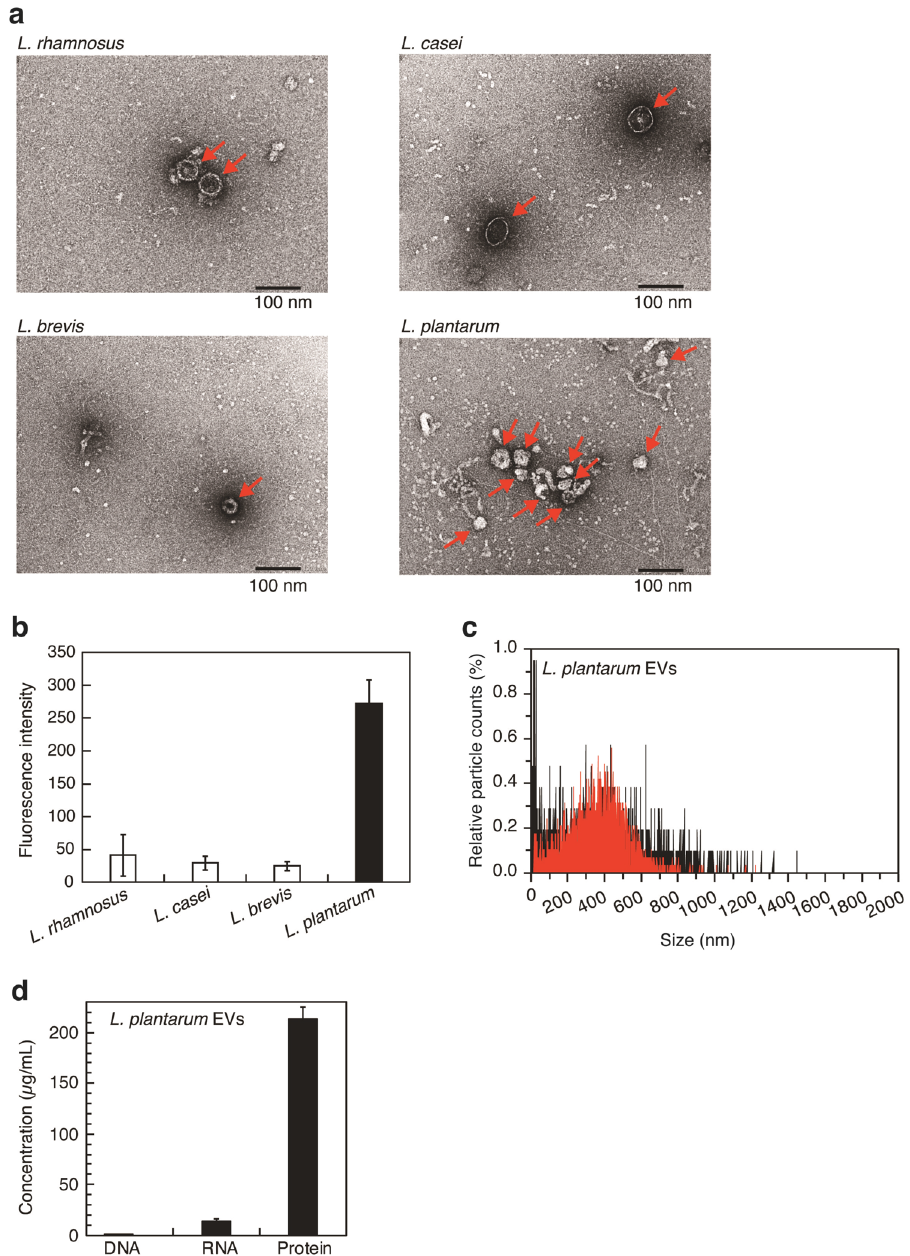
Figure 2. Characterization of EVs produced by L . plantarum. ( a ) TEM images of lactobacillus EVs. Red arrows indicate EVs. Scale bar, 100 nm. ( b ) EVs production of lactobacilli. Means ± SD, n = 3. ( c ) Size distributions of EVs (black: all particles in the L . plantarum EVs fraction, red: EVs labeled with FM4-64). The total numbers of particles in L . plantarum EVs and those of particles labeled by FM4-64 in L . plantarum EVs are represented as 100%. ( d ) DNA, RNA, and protein in L . plantarum EVs. Means ± SD, n =